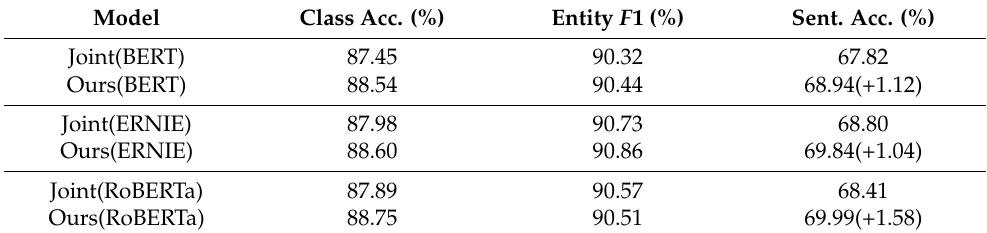
Table 4. Results under different pre-trained language